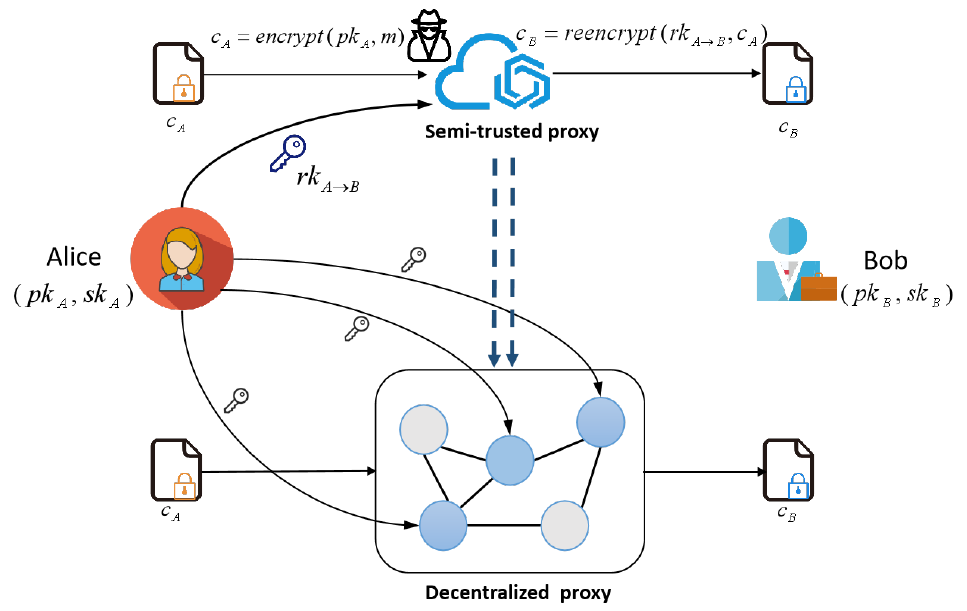
Figure 2. The comparison between third-party proxy servers and decentralized proxy servers. Threshold proxy re-encryption delegate re-encryption to multiple proxy nodes